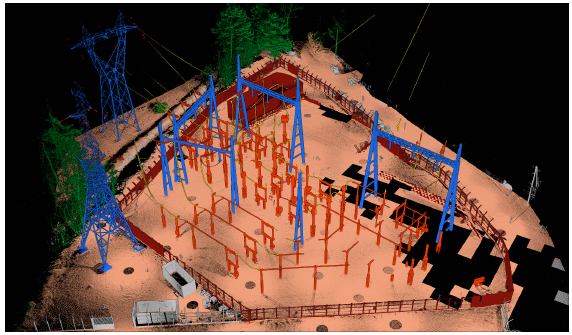
Figure 1. Classified 3D point cloud of an electrical substation. Each colour represents a different type of